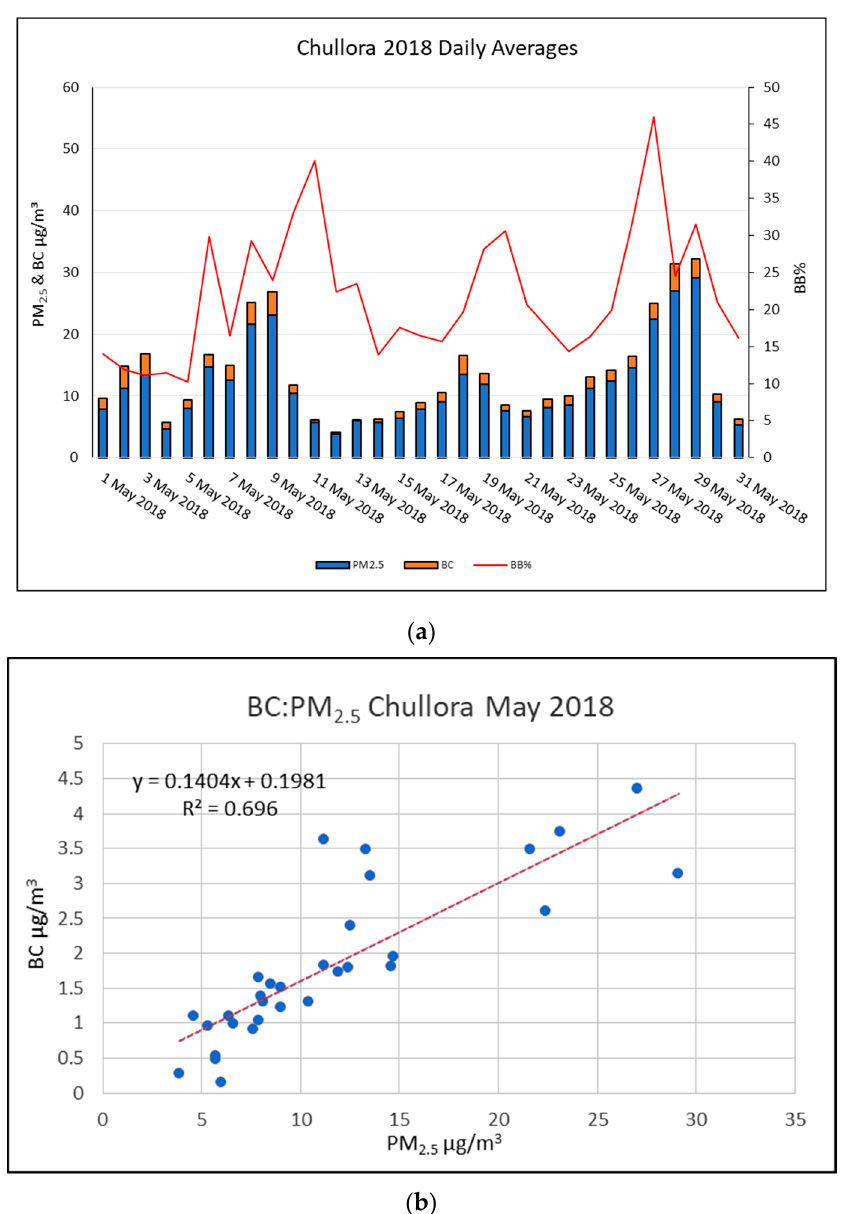
Figure 18. ( a ) Aerosols measured by CALIOP in the daytime transect from ( − 71.33, 170.53) to ( − 23.94, 145.72) on 7 May 2016 532 nm total attenuated backscatter; ( b ) profile of aerosol subtypes (1–10) with black colour representing the elevated smoke aerosol type (subtype 6); and ( c ) the satellite path (pink) corresponding to the lidar vertical aerosol profile in ( a,b ).